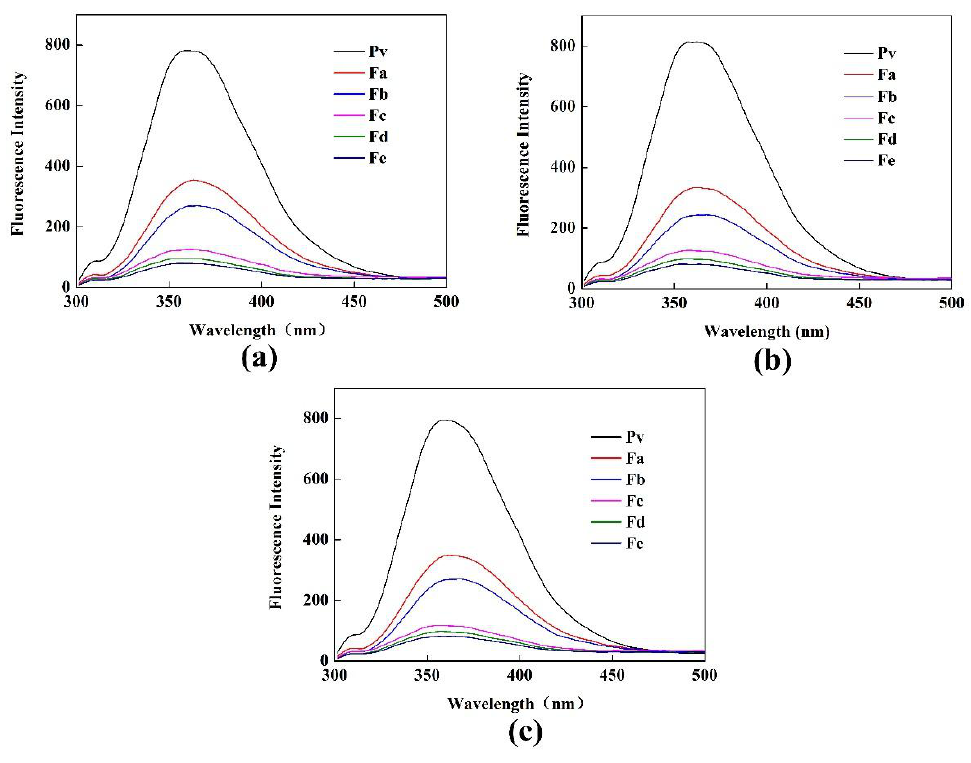
Figure 7. Fluorescence spectroscopy at ( a ) 298 K; ( b ) 304 K; ( c ) 310 K.